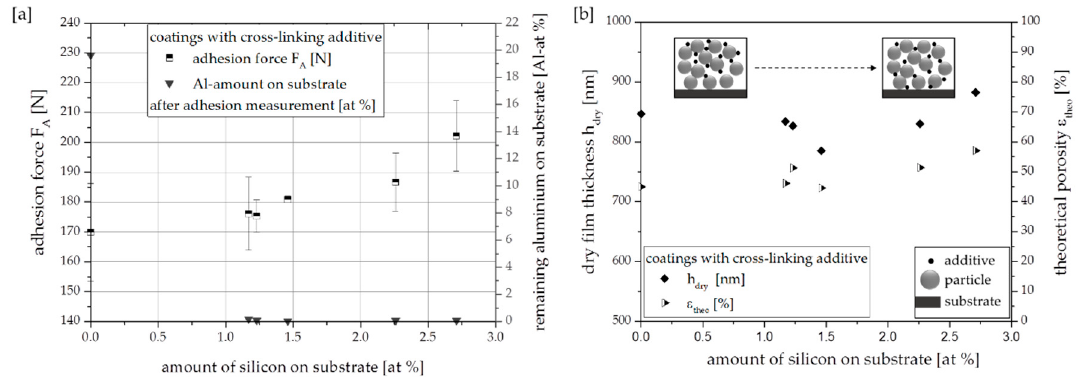
Figure 5. Coating with cross-linking additive: measured adhesion forces and remaining aluminium on substrate ( a ); dry film thickness and theoretical porosity ( b ).